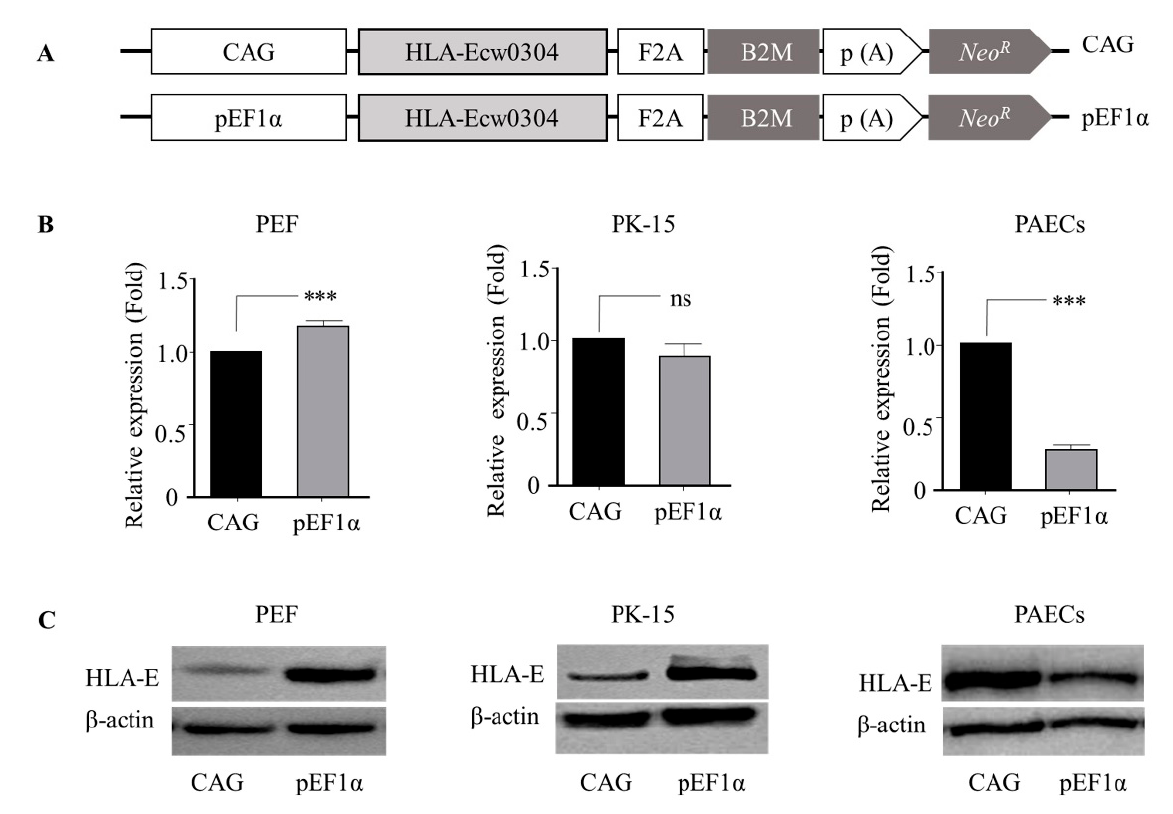
Figure 3. Comparative activity of the pEF1 α promoter with that of the CAG promoter in regulating an immunomodulatory gene in different types of porcine cells. ( A ) Schematic of the cassettes for HLA-Ecw0304 and B2M (HLA-E) co-expression. Comparative expression of mRNA levels ( B ) and protein levels ( C ) of HLA-E in PEFs, -15 cells, and PAECs. pEF1 α , porcine elongation factor 1 α ; HLA-E, human leukocyte antigen E; F2A, 2A self-cleaving peptides; B2M, β -2 microglobulin; p(A), poly A; Neo ®® , neomycin resistance. PEFs, porcine ear skin fibroblasts; PAECs, porcine aortic endothelial cells. ***, p < 0.001.